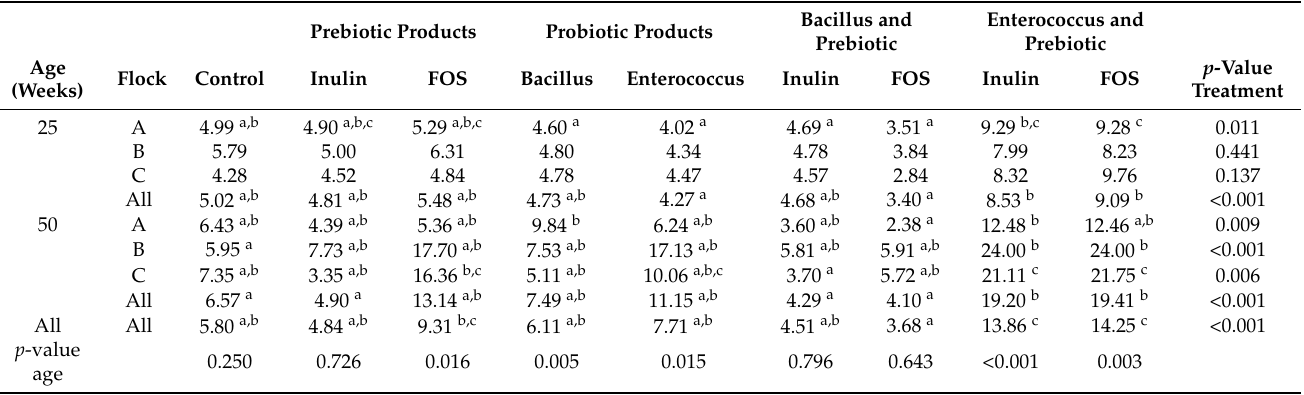
Table 2. Impact of pre- and probiotic products on the lag time of a pathogenic Escherichia coli O1/O18 strain after incubation in caecal slurries [h].